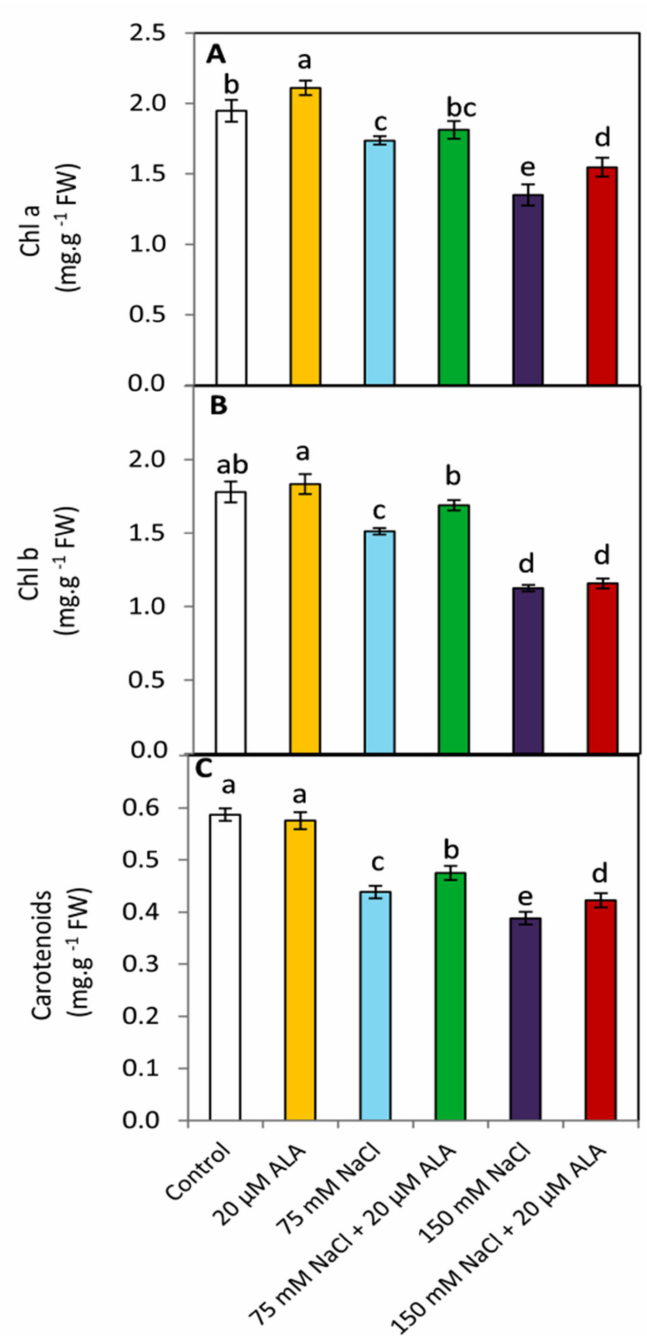
Figure 3. Effect of salinity stress as NaCl (0, 75 and 150 mM) and the foliar application by α -lipoic acid (ALA; 0 and 20 µ M) on the leaf photosynthetic pigments of sorghum plants including ( A ) chlorophyll a, ( B ) chlorophyll b and ( C ) carotenoids. For each parameter, the mean values ± SD followed by a different letter are significantly ( p ≤ 0.05) different according to Tukey’s range